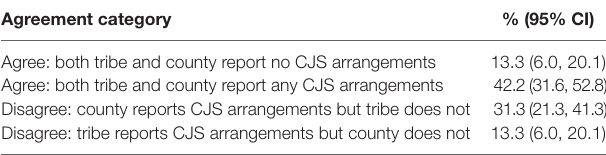
Table 2 | Tribe–county CJS agreement ( n = 83).